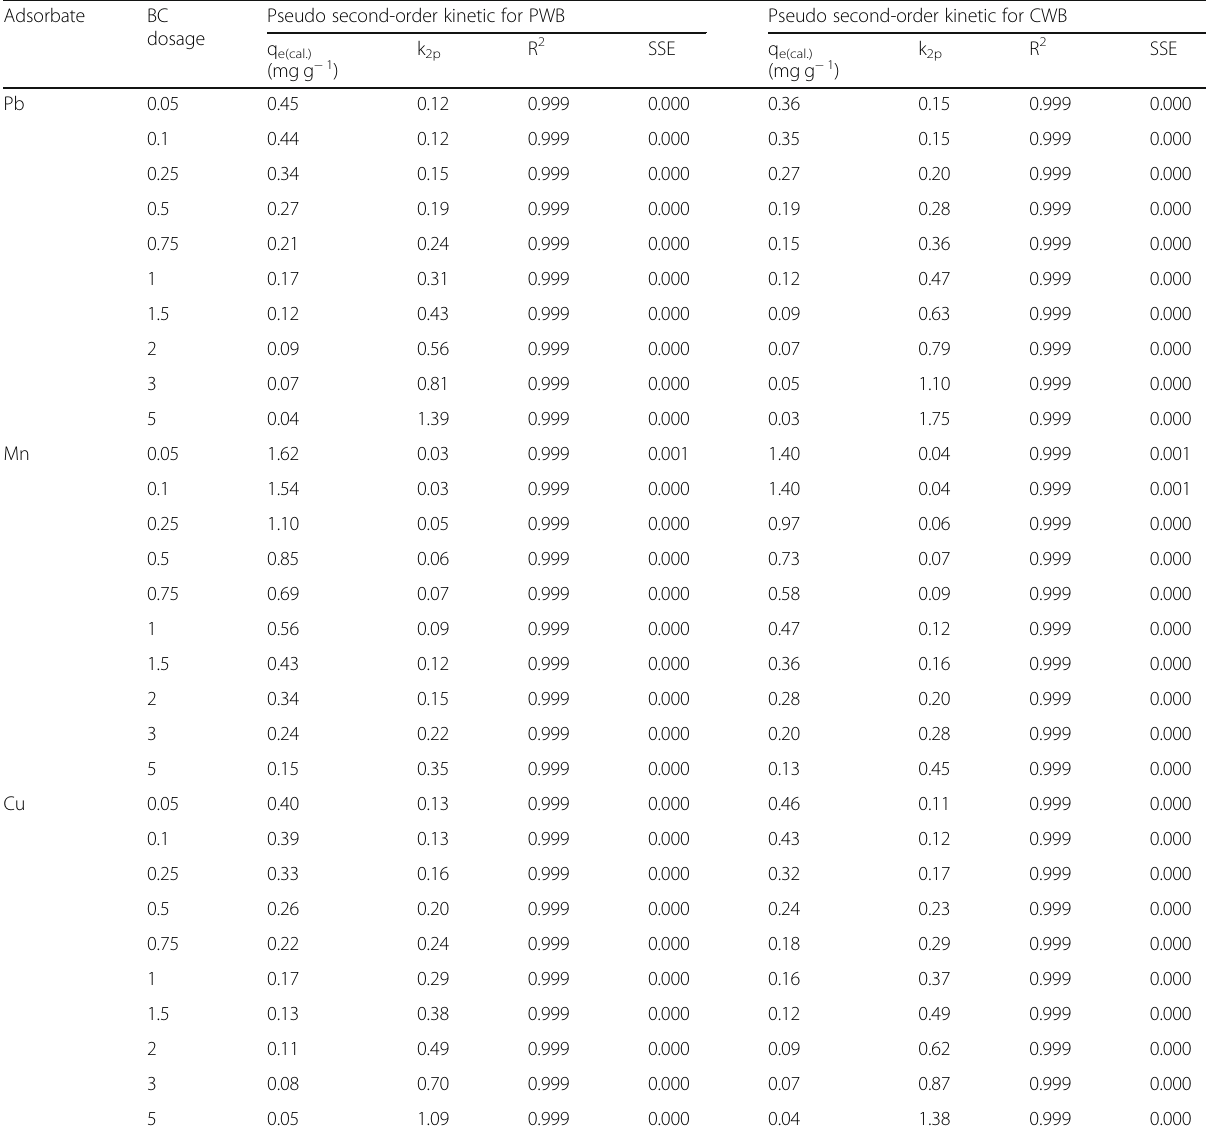
Table 1 Kinetic parameters of the pseudo second-order model for adsorption of heavy metals onto BC in landfill leachate Adsorbate BC Pseudo second-order kinetic for PWB Pseudo second-order kinetic for dosage